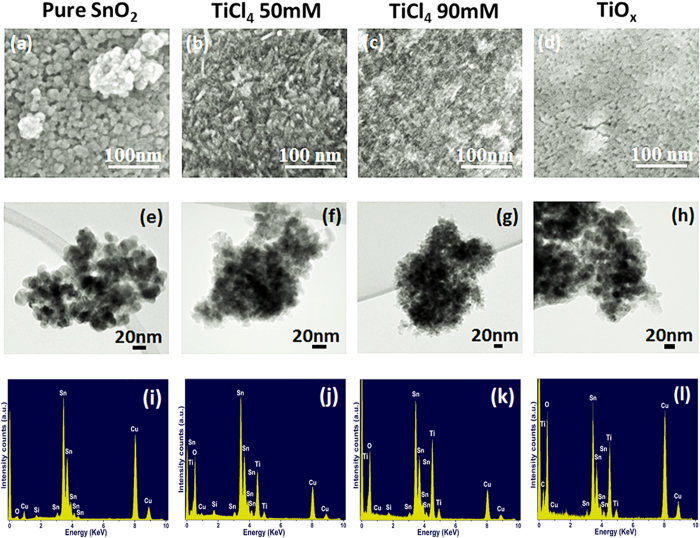
SEM images (a–d), TEM images (e–h), and EDX spectra (i–l) on different SnO2 photoanodes, confirming the presence of the constituent elements, SnO2 anodes: (a,e,i) before treatment; (b,f,j) treated with 50 mM TiCl4; (c,g,k) treated with 90 mM TiCl4; (d,h,l) treated with TiOX.